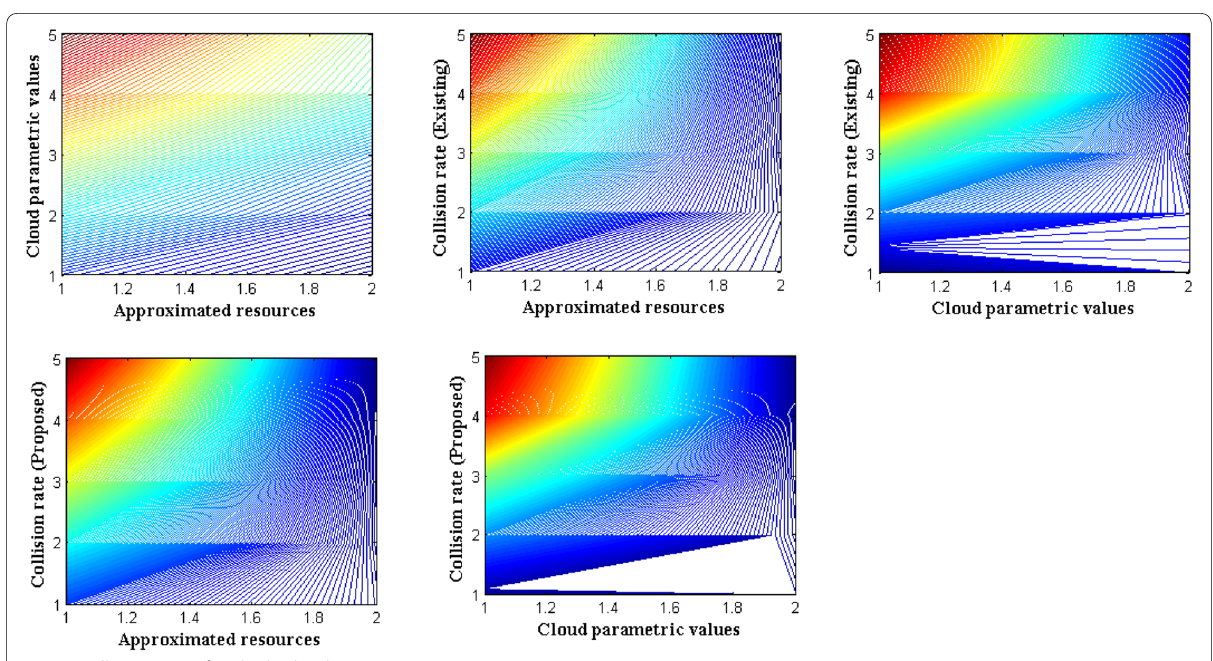
Fig. 4 Collision rates of multiple cloud metrics